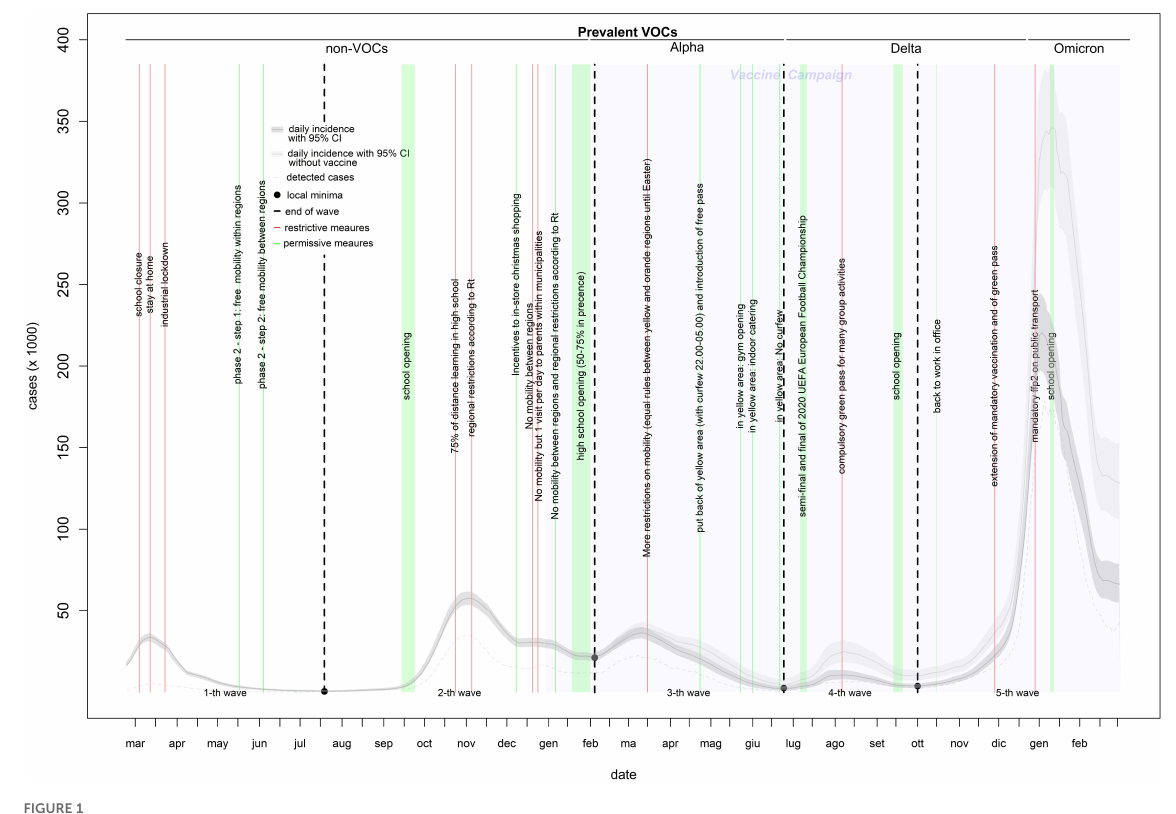
FIGURE1 Daily incidence of COVID-19 in Italy (February